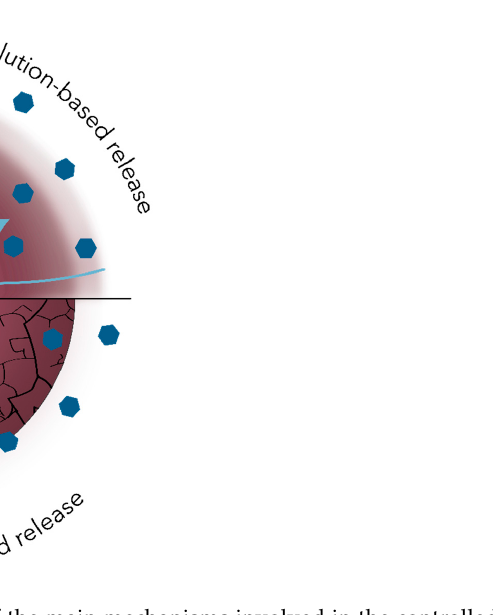
Figure 4. Schematic representation of the main mechanisms involved in the controlled release of antimicrobial drugs.